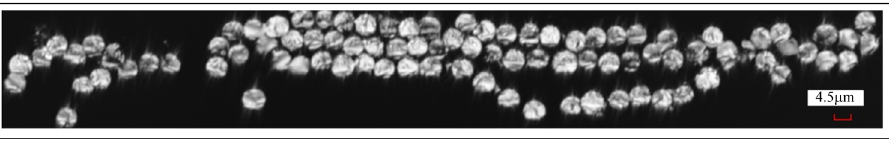
Figure 13: Observation of the fi ber strati fi cation of a yarn ’ s cross